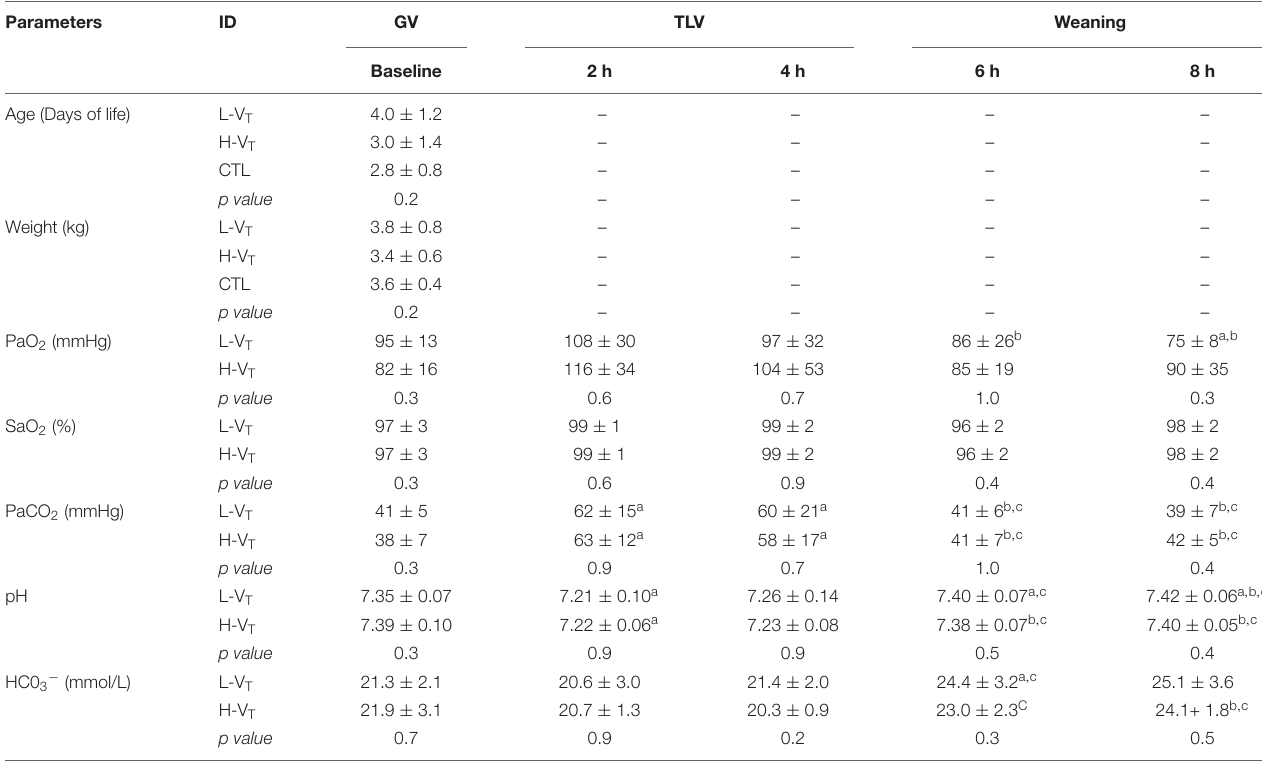
TABLE 1 | Lamb characteristics at baseline and blood